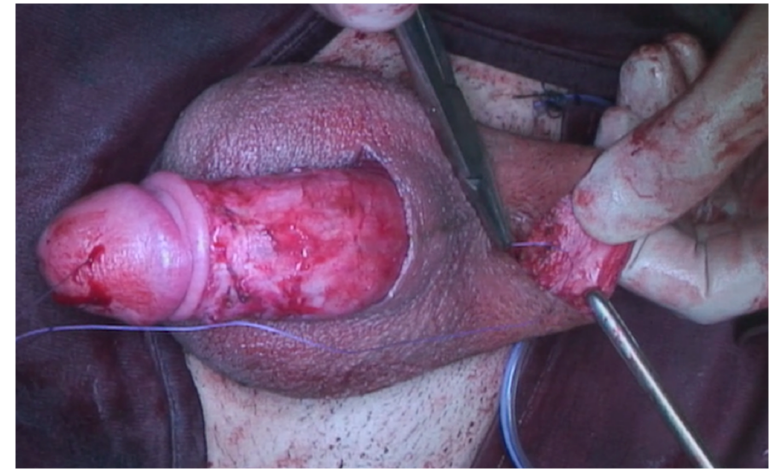
Figure 4. The defect was measured in length and girth.